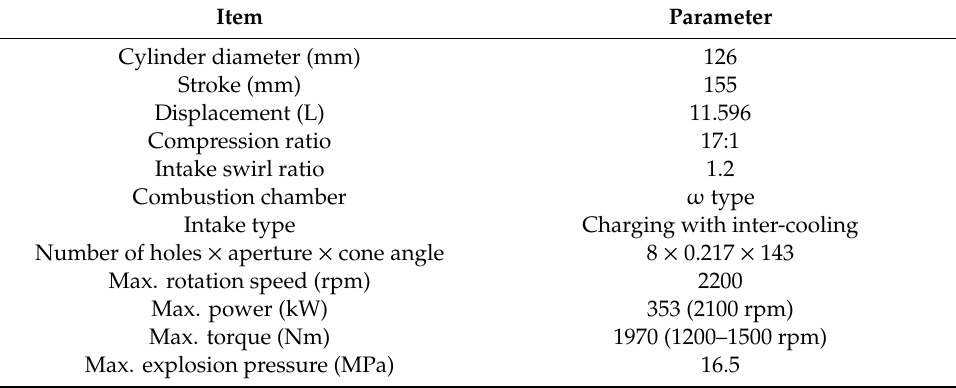
Table 1. Technical Parameters of a WP12 Heavy-duty Diesel Engine.